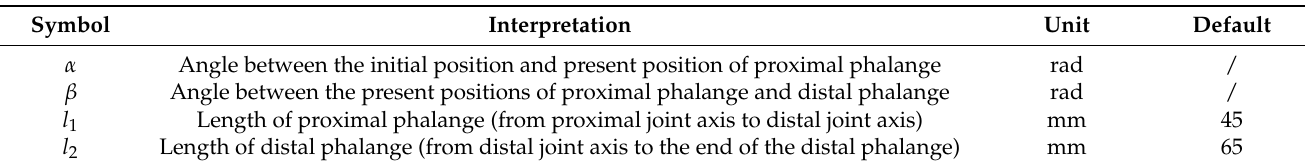
Table 2. Parameters used in the model of the ESMGM